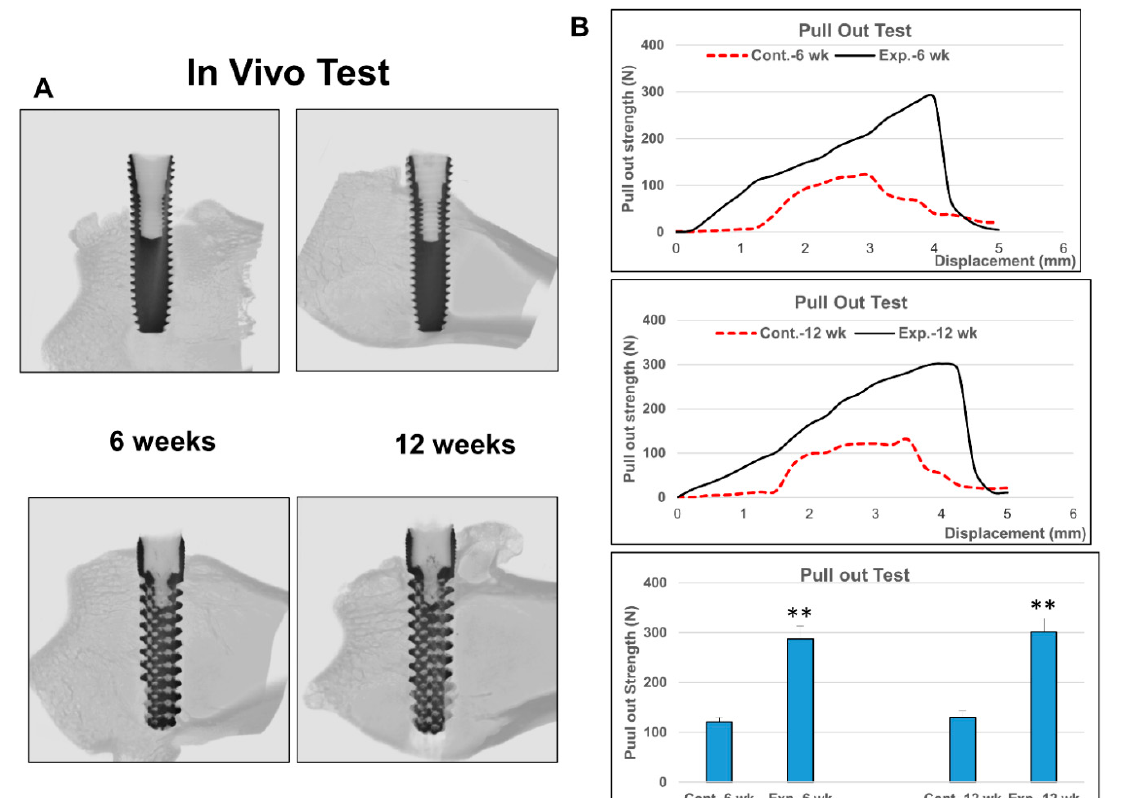
Figure 5. Biocompatibility and biomechanical parameters of the biomimetic DMLS Ti 6 Al 4 V dental implants in animal experiments (n = 6 in each group). ( A ) Micro-computed tomography analysis showed good incorporation of bone onto the threads of type #4 non-porous dental implant and into the porous scaffold structures of the type #6 dental implant. ( B ) Mechanical tests showed significantly higher pull-out strength (2.4 folds) for the type #6 porous dental implants at both 6 and 12 weeks. (** indicates significant differences when compared to #4 non-porous dental implant).